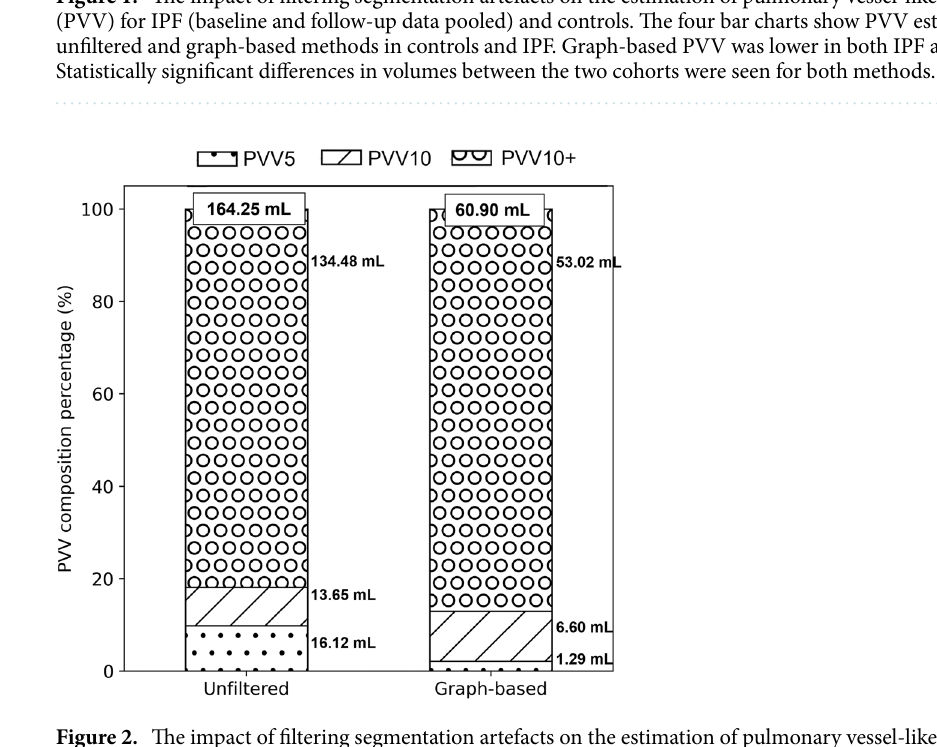
Distributions of vessel-like sub-volumes. Table 2 compares the absolute and relative (to PVV) size of each estimated sub-volume for IPF at baseline and controls. Only the baseline data for IPF were included here to investigate the difference from controls at the earliest imaging of the disease. The absolute values were higher in IPF for all sub-volumes. For the relative volumes, PVV10 + and PVV10 as a proportion of estimated PVV were not different between the cohorts, but PVV5 as a proportion of estimated PVV was lower in IPF compared with controls. Repeating this comparison using pooled baseline and follow-up data for IPF (Fig. 3) concluded the same trends and strength of relationships: p values were 0.002 (PVV5), < 0.001 (PVV10 and PVV10 +) for absolute values, and only PVV5 was different ( p = 0.02) for relative values. Estimated PVV had positive relationships with all the subvolumes. Table 3 provides the slope estimates and respective p-values showing the significance of these relationships.